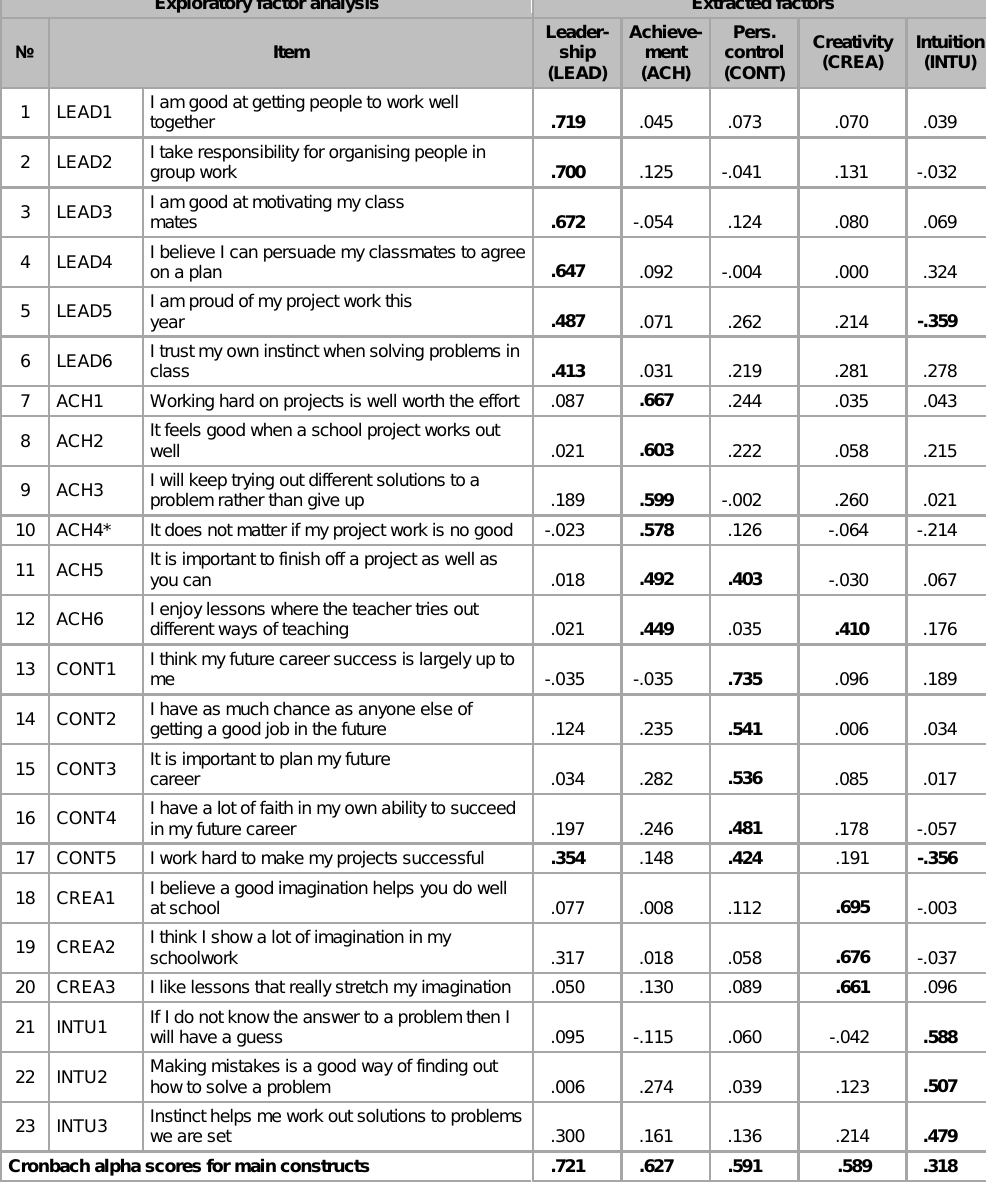
Exploratory factor analysis (Varimax) for the ATE Test ( n = 1 748) Extracted factors